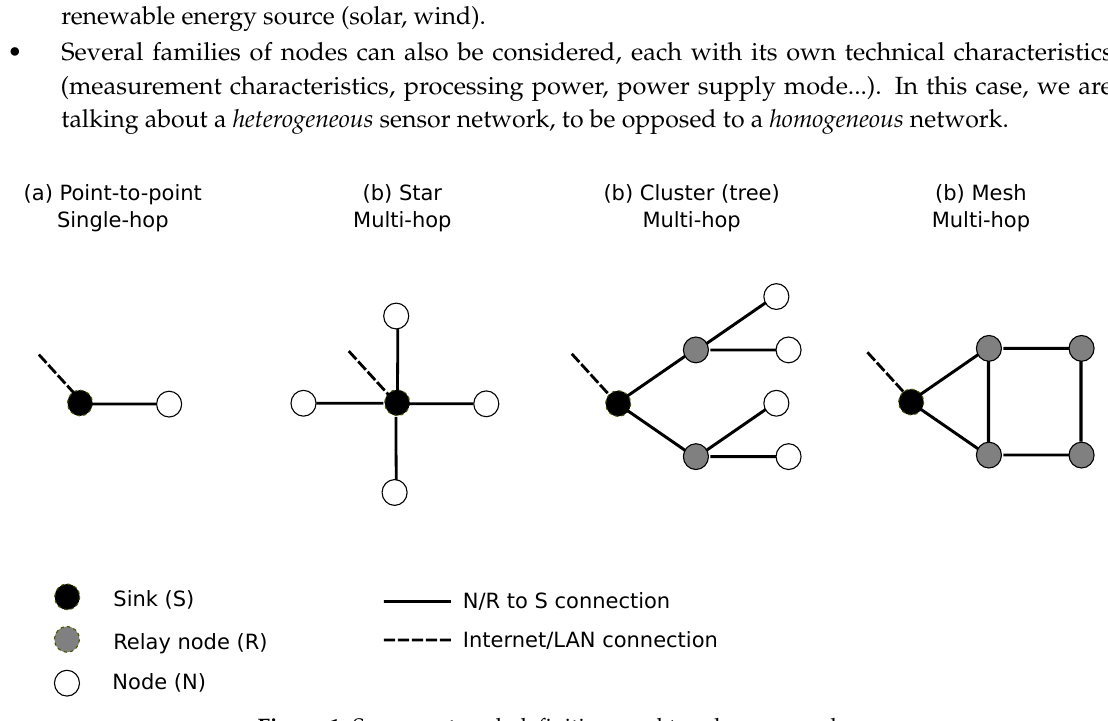
Figure 1. Sensor network definitions and topology